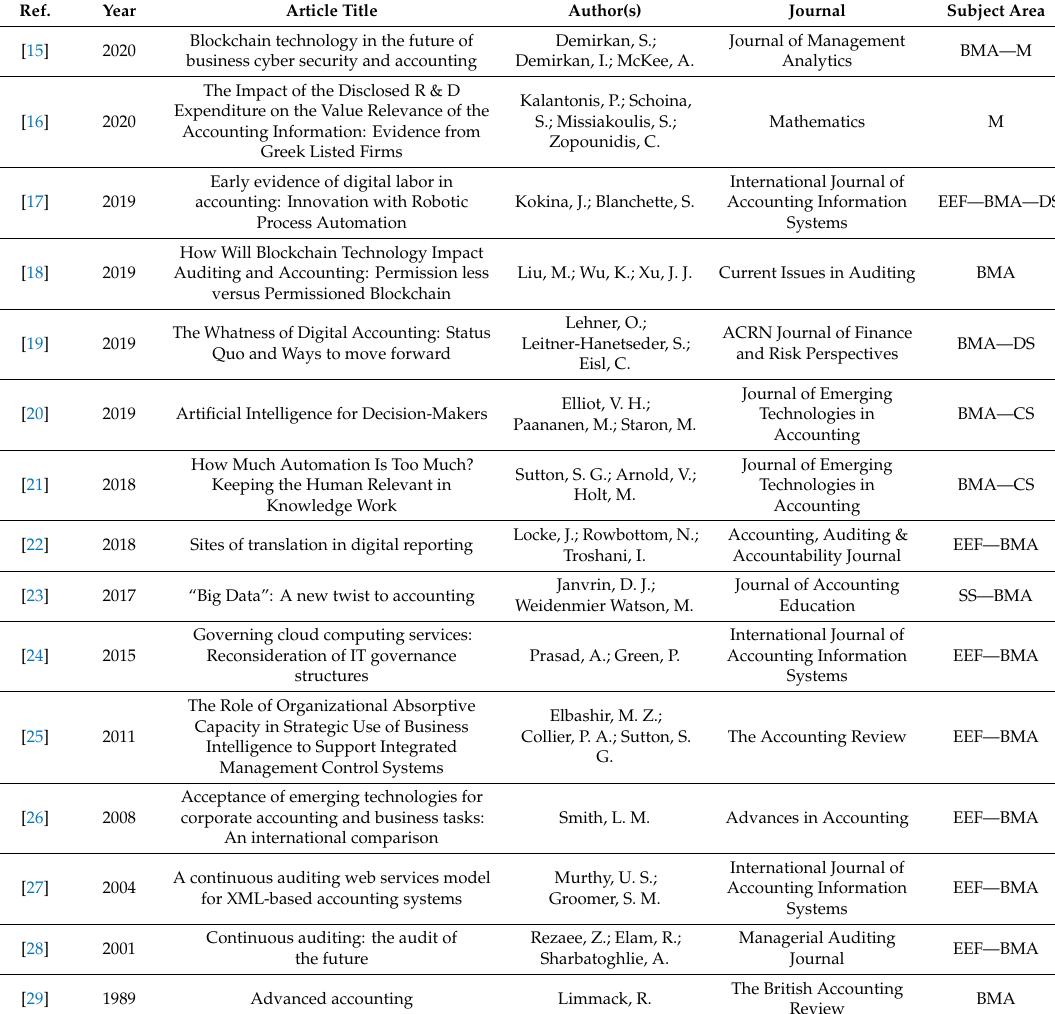
Table 1. Main literature reviewed to define the scope of the study.